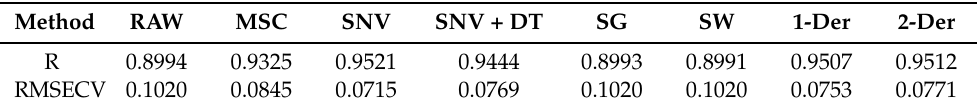
Table 2. Modeling results of different processing